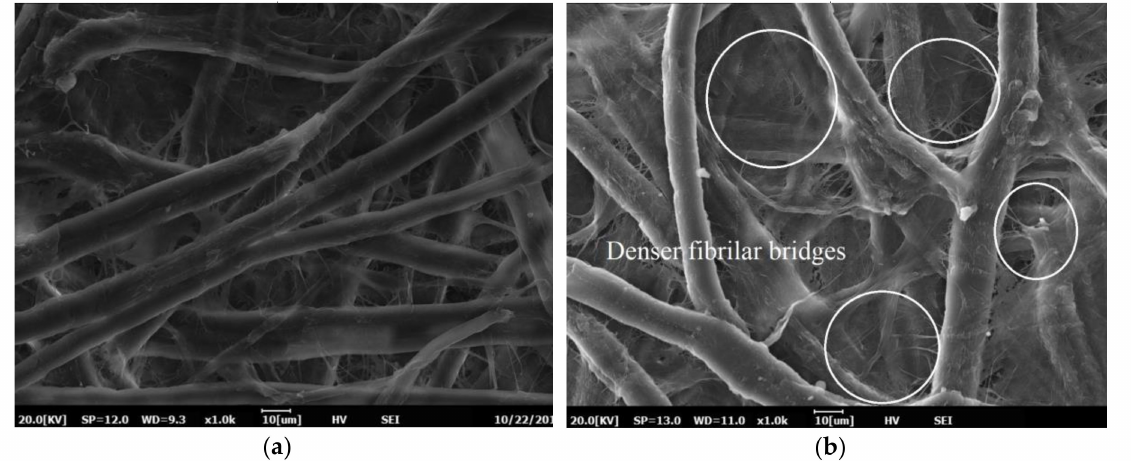
Figure 16. SEM images of Kenaf paper: ( a ) beaten at 12,000 revolutions; and, ( b ) beaten at 12,000 revolutions and 12% PVA.